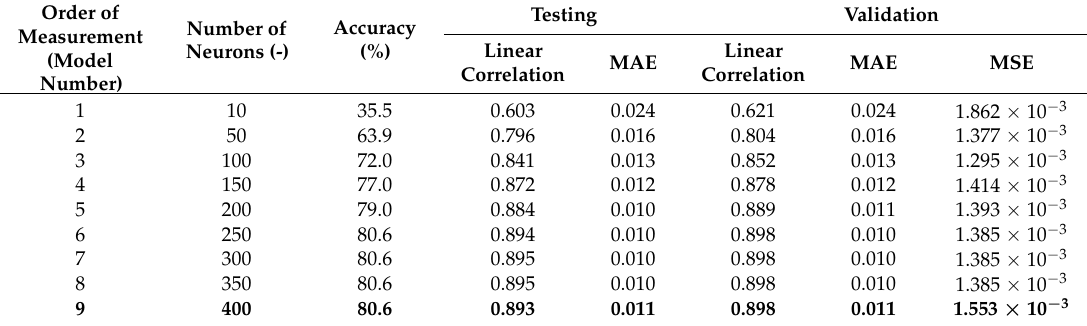
Table 2. The trained models—Training period: November 2018.